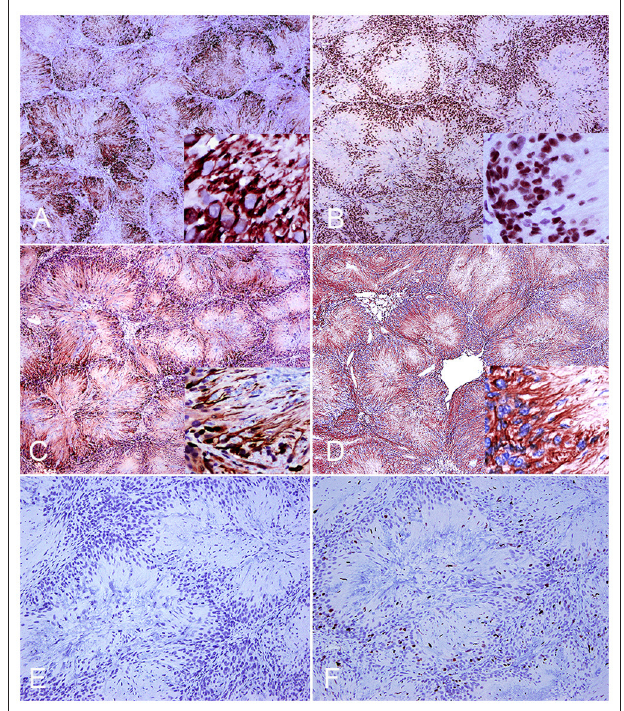
FIGURE 2 | Neuroblastoma-like schwannoma, cat, subcutaneous mass. Immunohistochemistry. Neoplastic Schwann cells cytoplasmic processes diffusely and strongly immunoreact to periaxin (A) . One hundred percent of nuclei of neoplastic cells are strongly positive for Sox-10 (inset) (B) . Neoplastic Schwann cell cytoplasmic processes immunoreact to S-100 (C) . Neoplastic fibrillary cytoplasmic processes are strongly labeled with glial fibrillary acid protein (D) . Immunohistochemistry for synaptophysin confirms lack of immunoreactivity of neoplastic cells (E) . Approximately 10% of the cells display nuclear ki-67 (MIB-1) immunostaining (F)